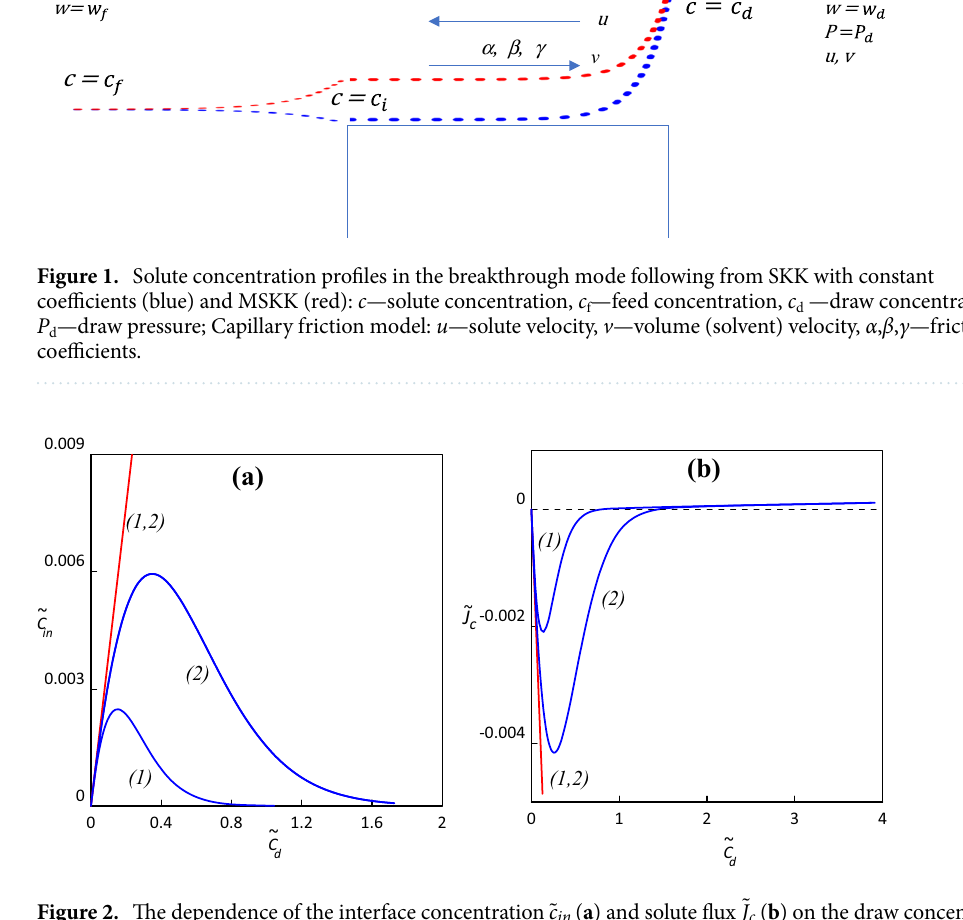
Figure 2. The dependence of the interface concentration ˜ c in ( a ) and solute flux ˜ c d for classical SKK (blue line) and modified MSKK (red line) equations, (1) σ